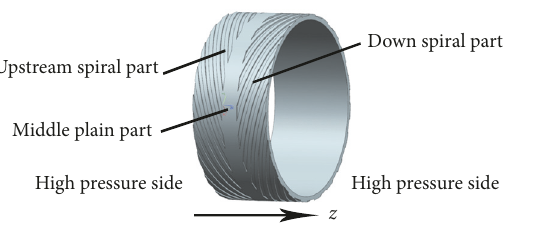
Figure 2: Hydraulic model of a smooth-rotor/herringbone- grooved-stator